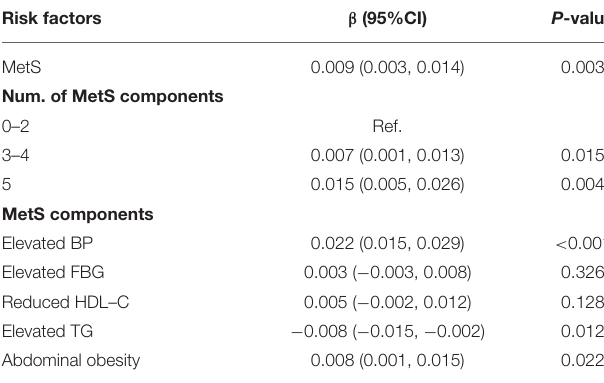
TABLE 4 | Multivariable liner regression analysis of relationship between MetS, MetS components, and number of MetS components and